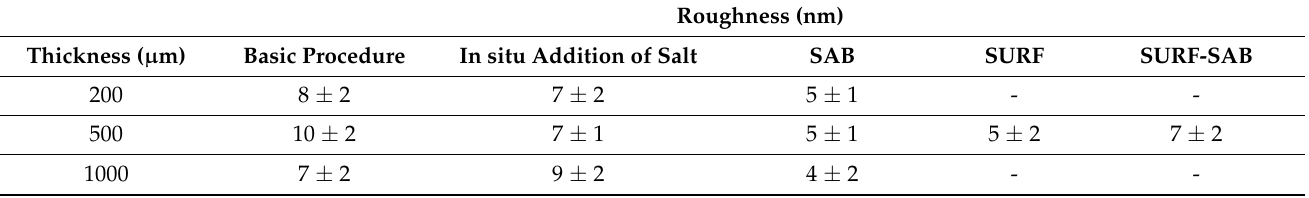
Table 1. Roughness (Rms) values of the membranes as a function of preparation conditions and thickness (scanning square areas of 2 µ m × 2 µ